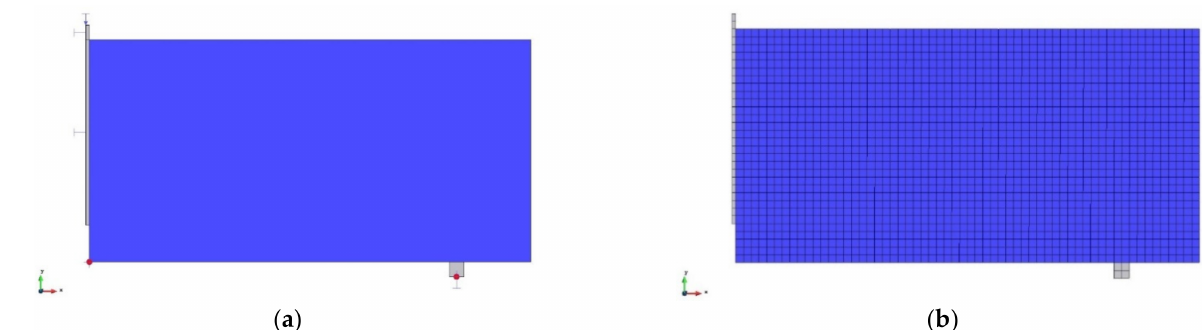
Figure 12. Numerical model of concrete beams: ( a ) the geometry and boundary conditions, ( b ) the model mesh.